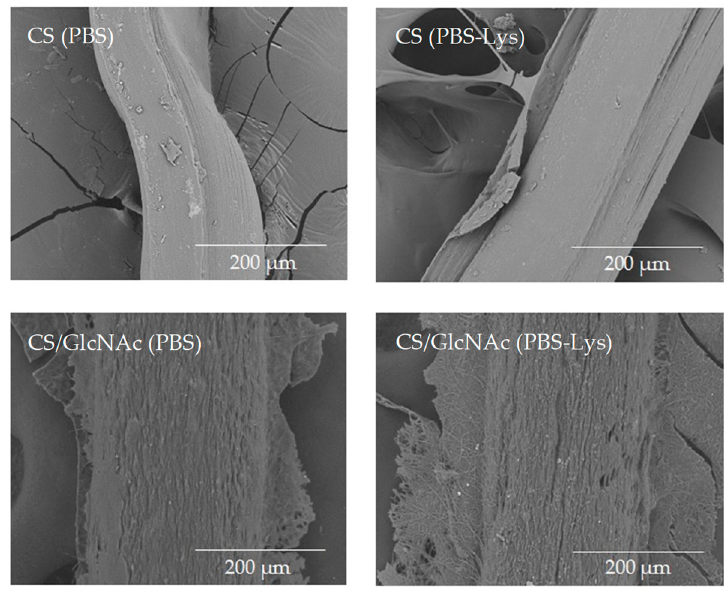
Figure 6. SEM images of the CS and CS/GlcNAc filaments after incubation in a phosphate buffered saline (PBS) solution and PBS–lysozyme (PBS–Lyz) at 37 ° C for 49 and 35 days,